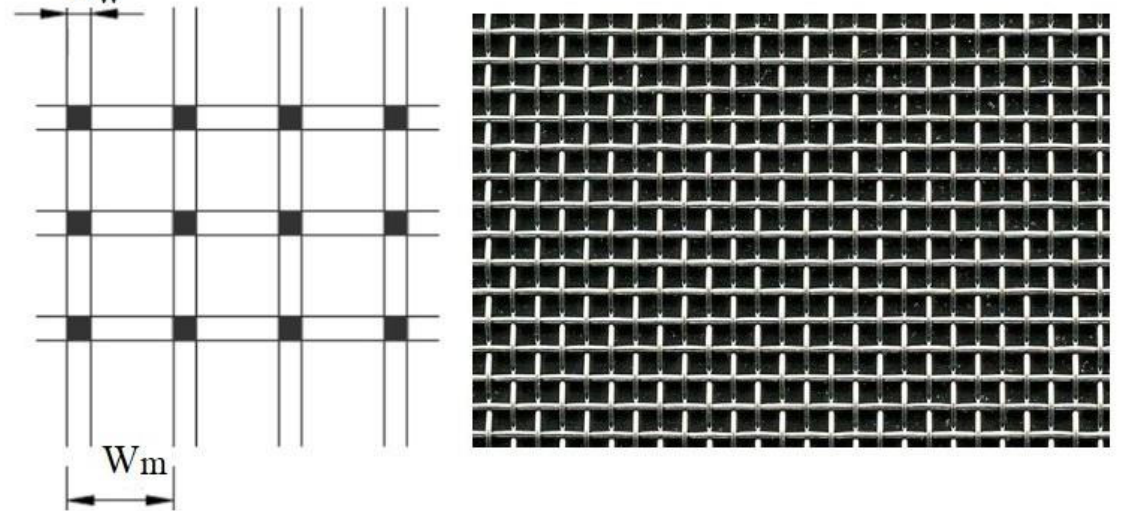
Figure 6. The mesh screen structure with the main dimensions.